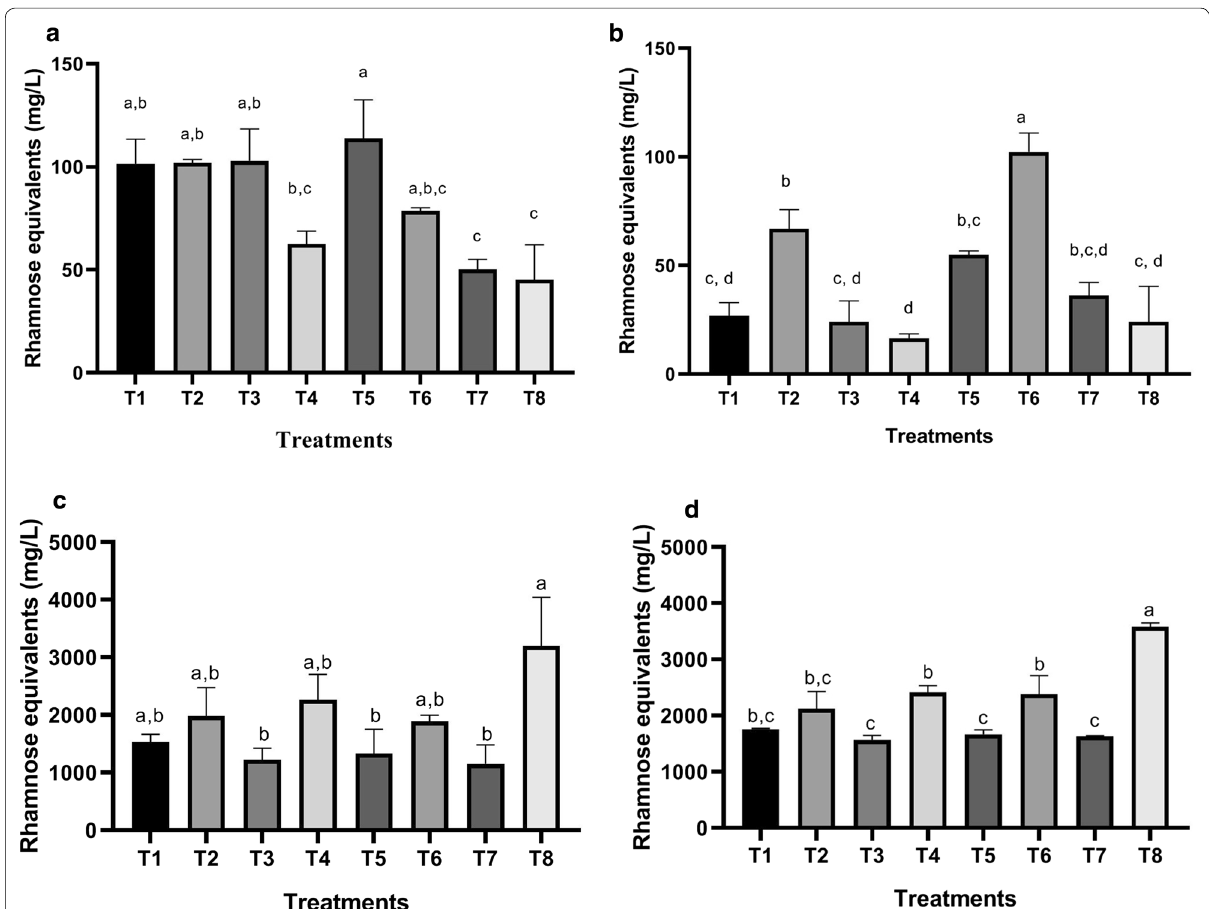
Fig. 1 The four full factorial designs used to optimize rhamnolipid production. The rhamnolipid yield is expressed as rhamnose equivalents. a Factorial design 1 (Canola Oil/(NH 4 ) 2 SO 4 ); b Factorial design 2 (Waste canola Oil/(NH 4 ) 2 SO 4 ); c Factorial design 3 (Canola Oil/(NaNO 3 ); d Factorial design 4 (Waste canola Oil/(NaNO 3 ). Treatments that do not share a letter are significantly different ( p <